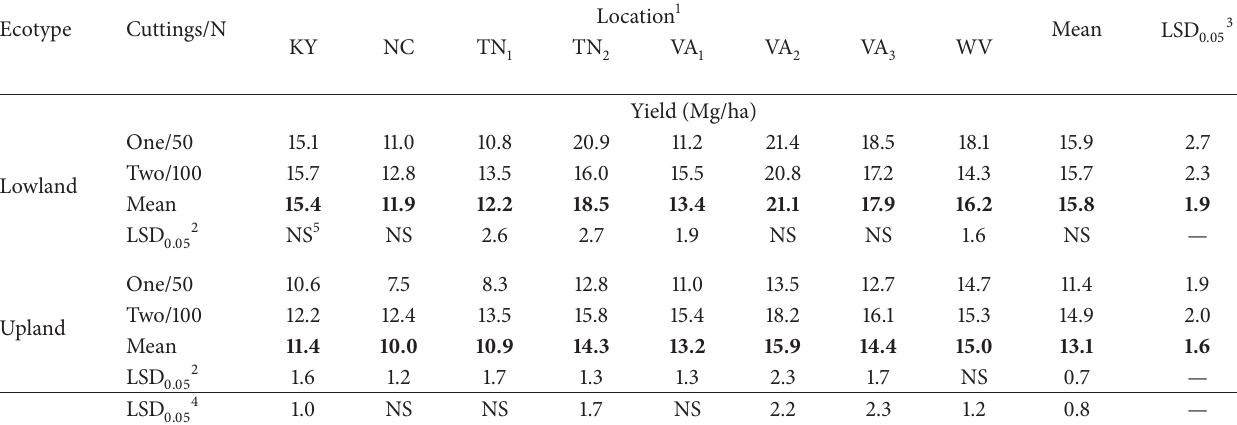
Table 8: Effect of ecotype and management (one-cut (low input and management) and two-cut (high input and management)) on yield of switchgrass at eight locations across upper southeast USA. Data are averaged across cultivars (Alamo + Kanlow = lowland; Cave-in-Rock + Shelter = upland) and 2 years.